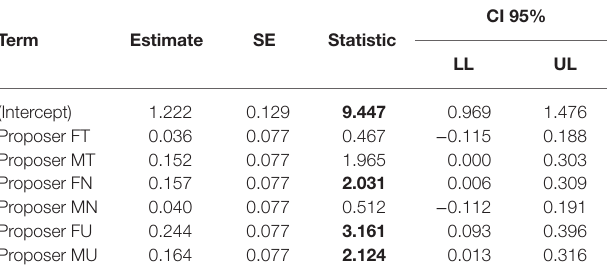
TABLE 6 | Fixed effects of proposer on probability discounting compared to